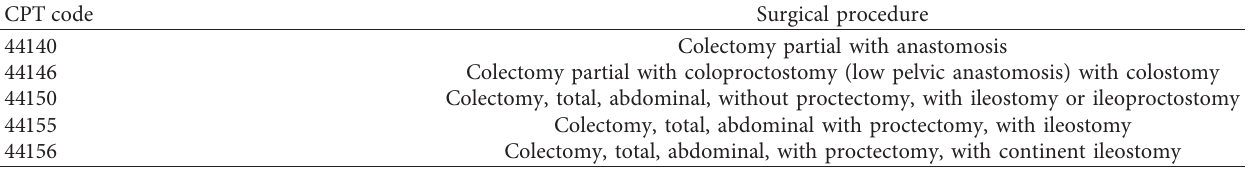
Table 1: Current Procedural Terminology codes with the associated surgical procedure.